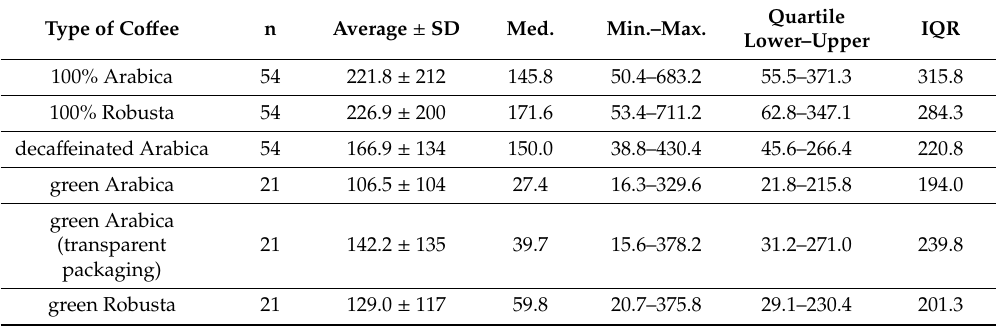
Table 1. Descriptive statistics of total phenolic content (mg GAE/100 g) in all tested infusions of various types of coffee.